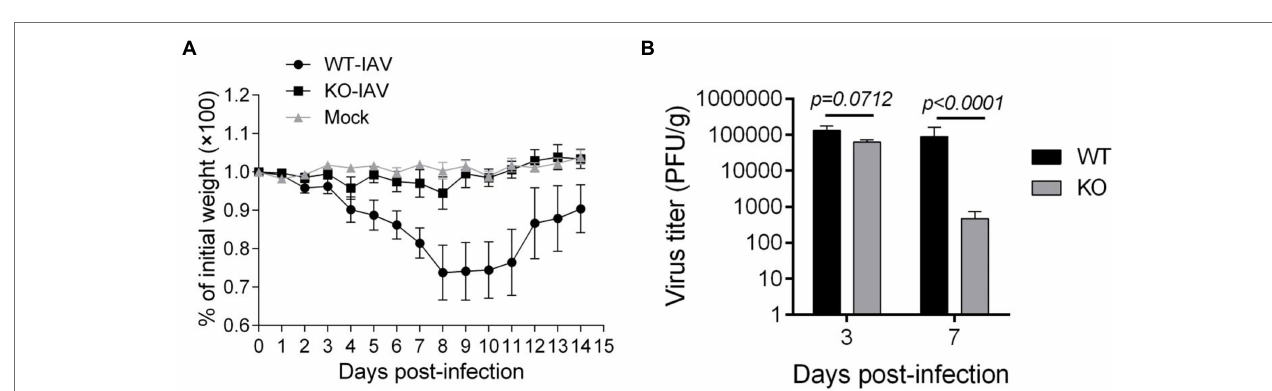
FIGURE 6 | IL16 deficiency reduces the susceptibility to IAV infection in mice. Seven-week-old male WT and IL16 KO mice were intranasally infected with PR8 virus (8,000 PFU/mouse), and control mice received mock inoculation with PBS. (A) Daily weights of each mouse were measured within 14 days after infection, 10 mice per group. (B) Lungs were collected from infected mice at day 3 and day 7 post-infection and pulmonary viral loads were measured by plaque assays using MDCK cells. Data shown are mean ± SD, 10 mice per group. A value of p < 0.05 was considered